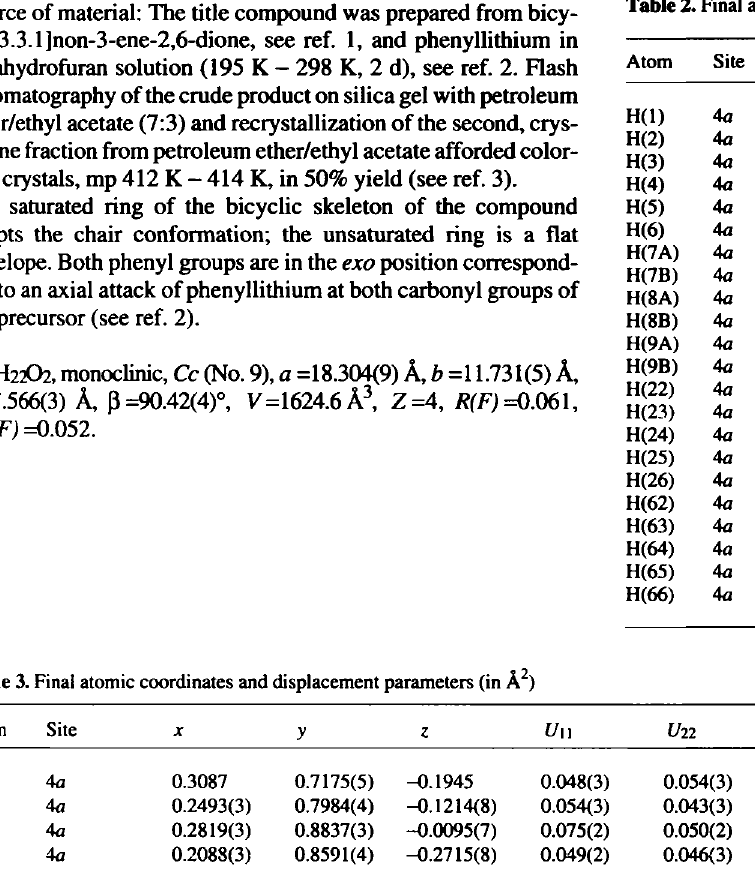
Table 3. Final atomic coordinates and displacement parameters (in